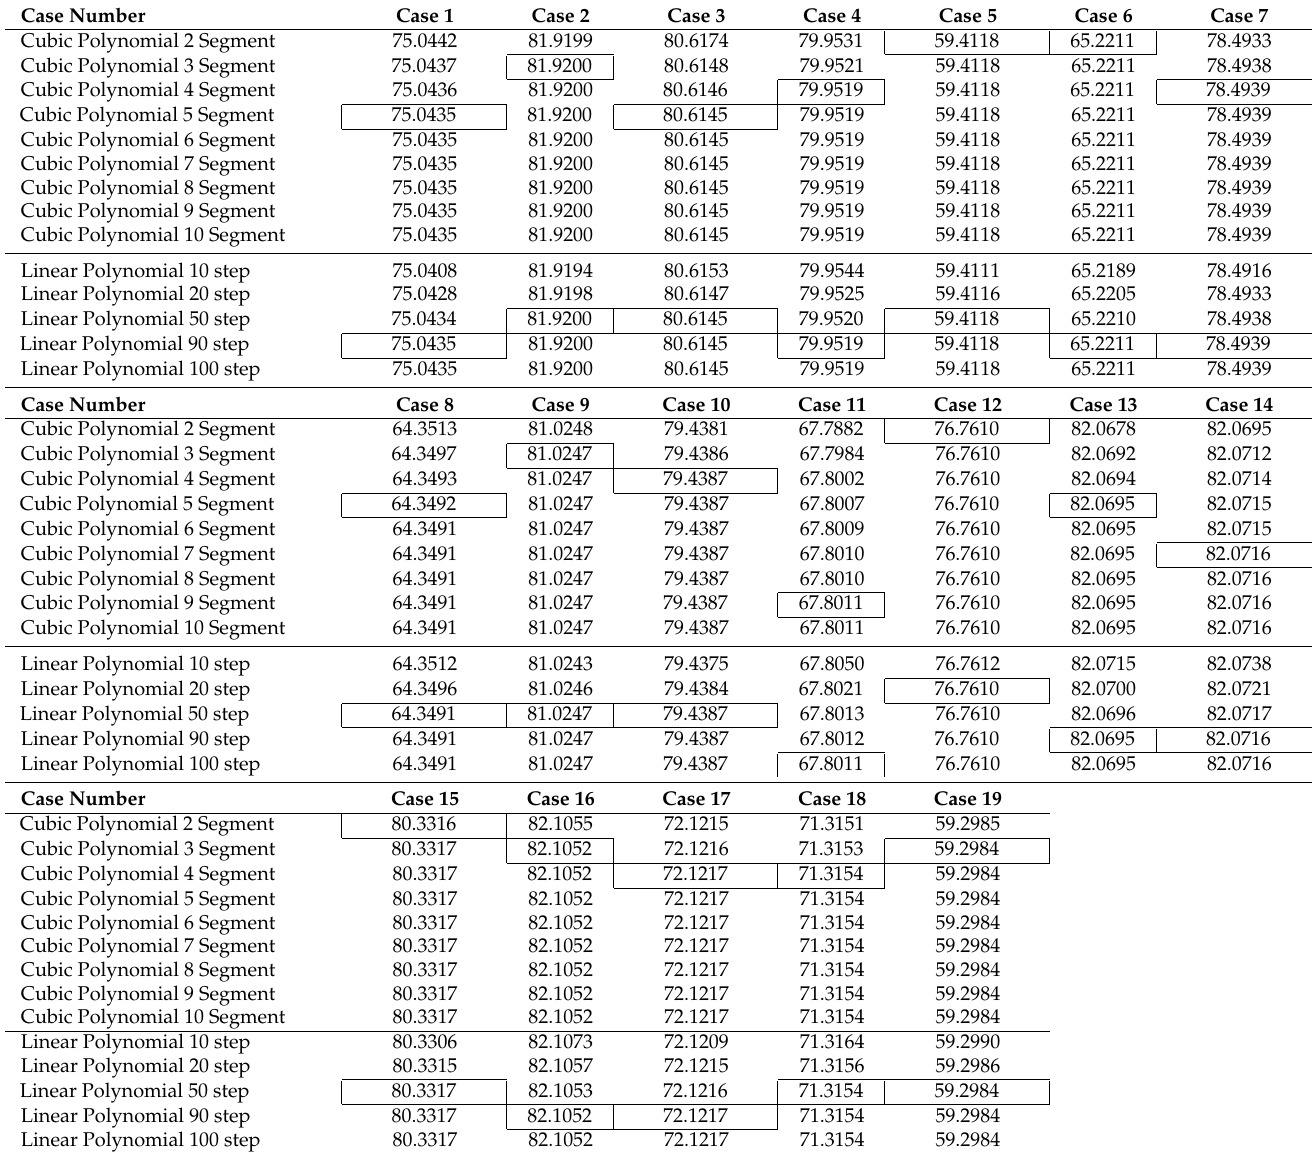
Table A3. Summary comparison of polytropic efficiency results for linear multi-step and cubic polynomial multi- segment